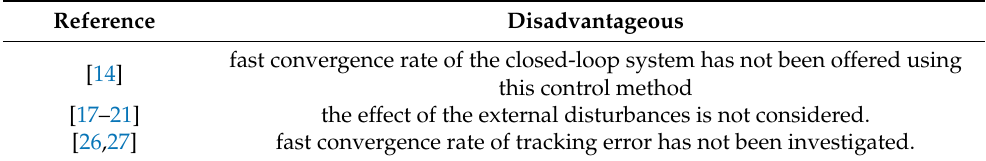
Table 1. Disadvantages of the existing methods.